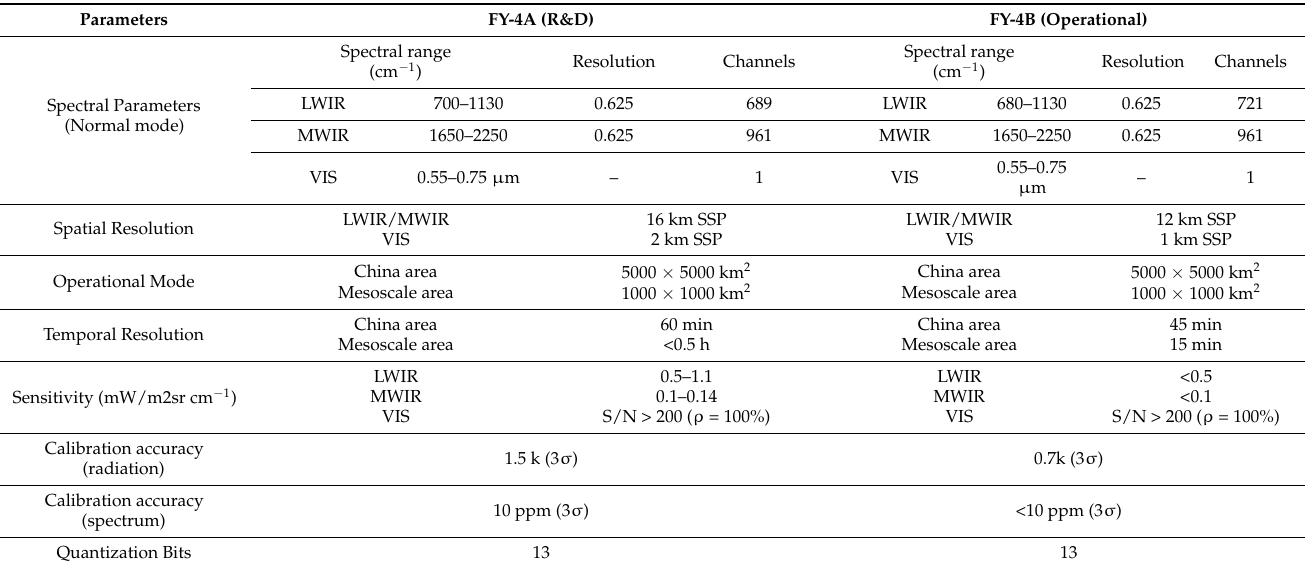
Table 2. The parameters of FY-4